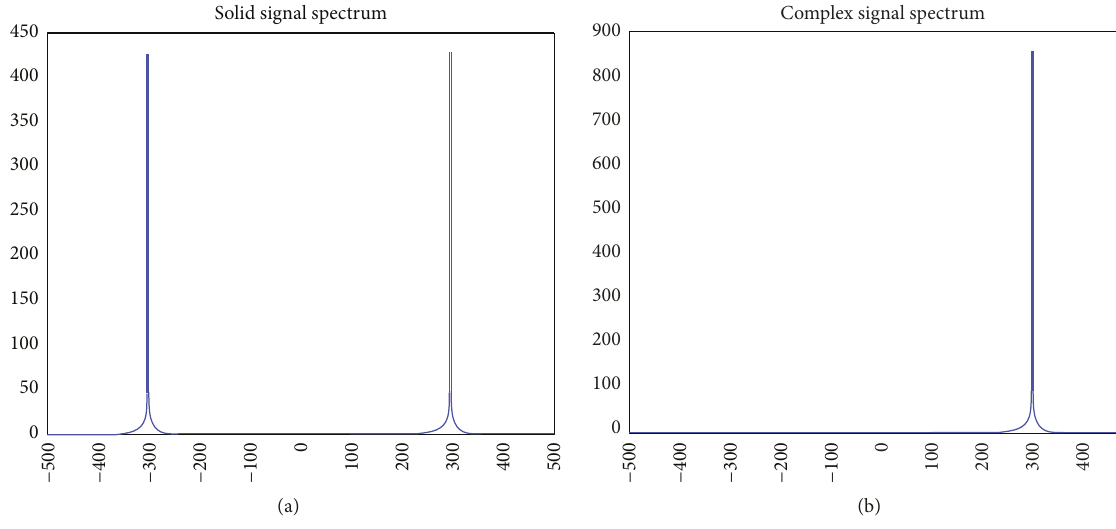
Figure 8: Signal spectrogram. (a) Spectrum diagram of real signal. (b) Spectrum diagram of complex signal.